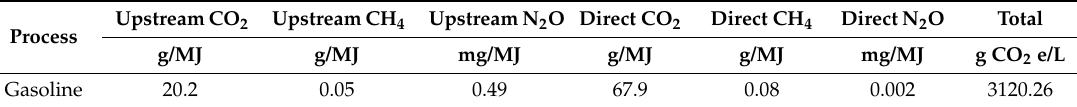
Table 12. Life cycle upstream and direct emission factors for gasoline in China [68].